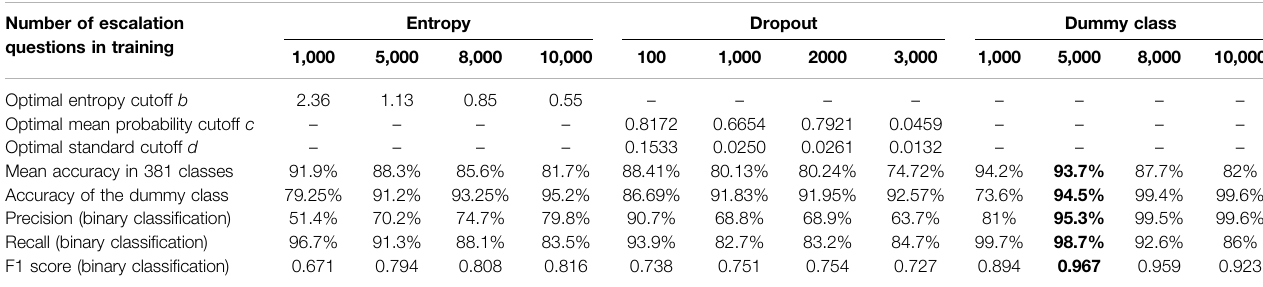
TABLE 3 | Performance of cross-comparison of three approaches evaluated on test data of the same size (906 relevant questions plus 4,000 escalation questions). Precision/recall/F1 scores were calculated assuming relevant questions are true positives. In entropy and dropout optimization processes, δ is set to 0.5. Other delta values for the dropout approach are listed in Supplementary Appendix